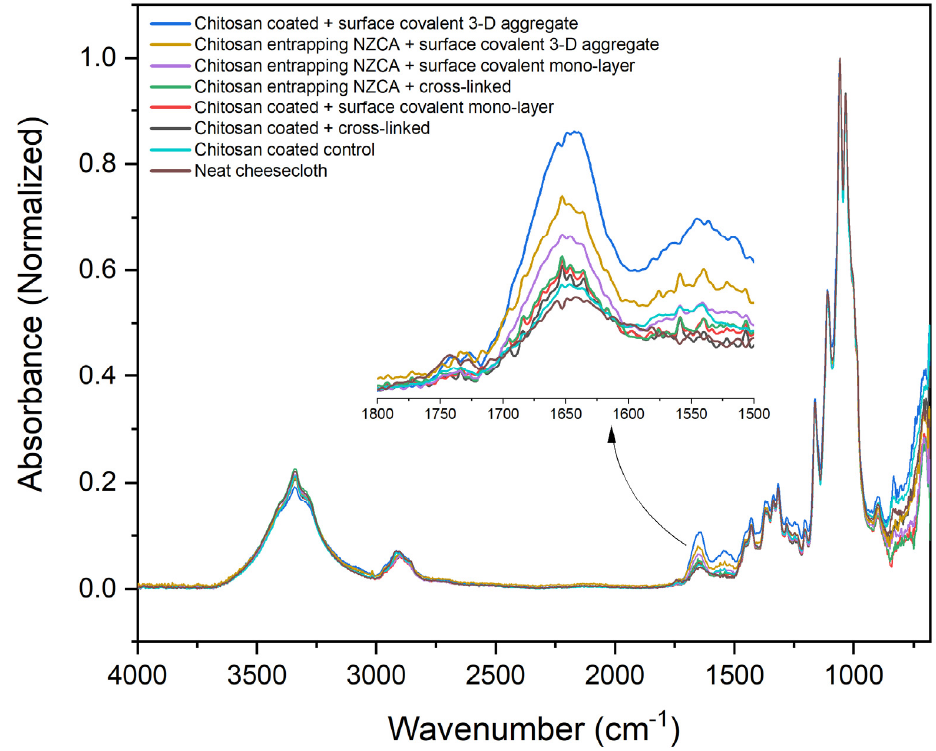
Figure 2. FTIR spectra of surface covalently immobilized NZCA (Chitosan coating + surface covalent attachment of NZCA), surface hybrid immobilized NZCA (Chitosan entrapping NZCA + surface covalent attachment of NZCA), and no-enzyme controls, all on cheesecloth support materials.